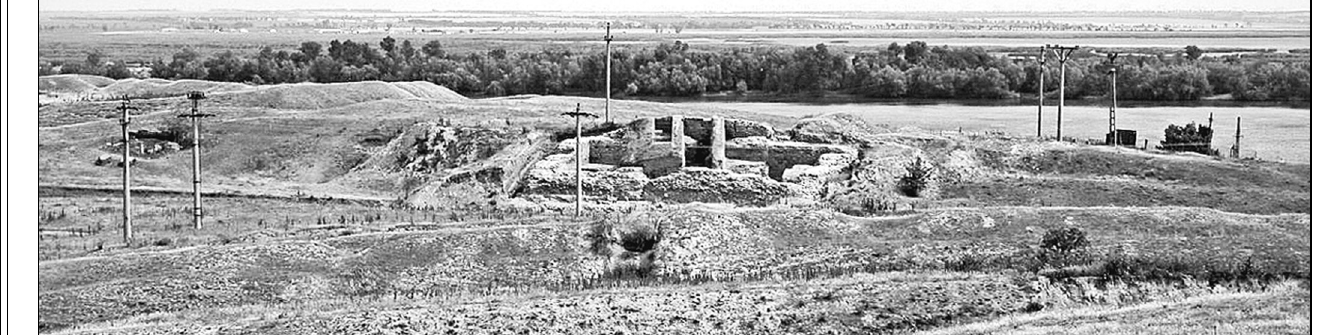
Figure 4 A view across Noviodunum from the south, showing the topographic complexity of the site. In the centre is the late-Roman tower under excavation by Victor Baumann in June 2002, and to the left the grass-covered remains of the Ottoman fortress are visible (see A and B in Figure